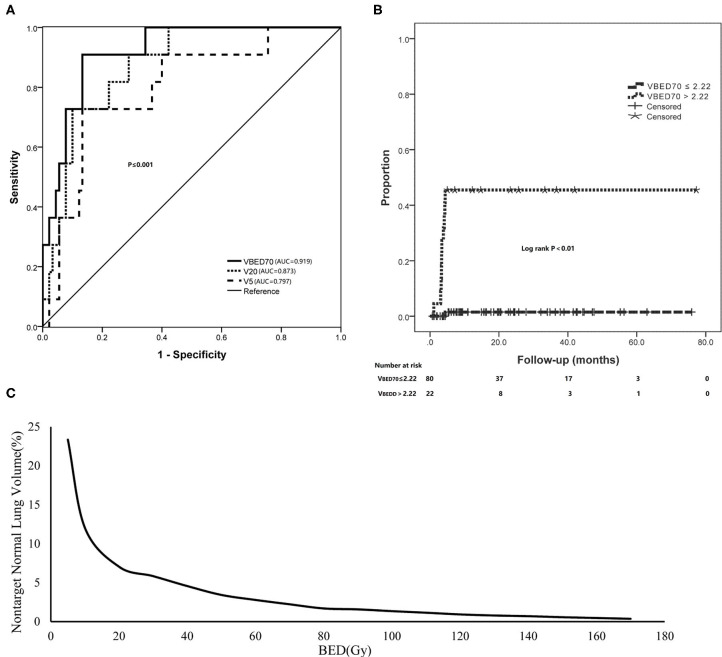
The adaption of BED of non-target lung volume for predicting SRP. (A) The ROC curve analysis of VBED70 in comparison with V5 and V20. (B) Using VBED70 (2.22%) as the dose constraint threshold dramatically reduced the incidence of SRP. (C) A sample BED-volume histogram (BEDVH) for non-target normal lung showed the tolerable and intolerable volumes corresponding to indicated BEDs.